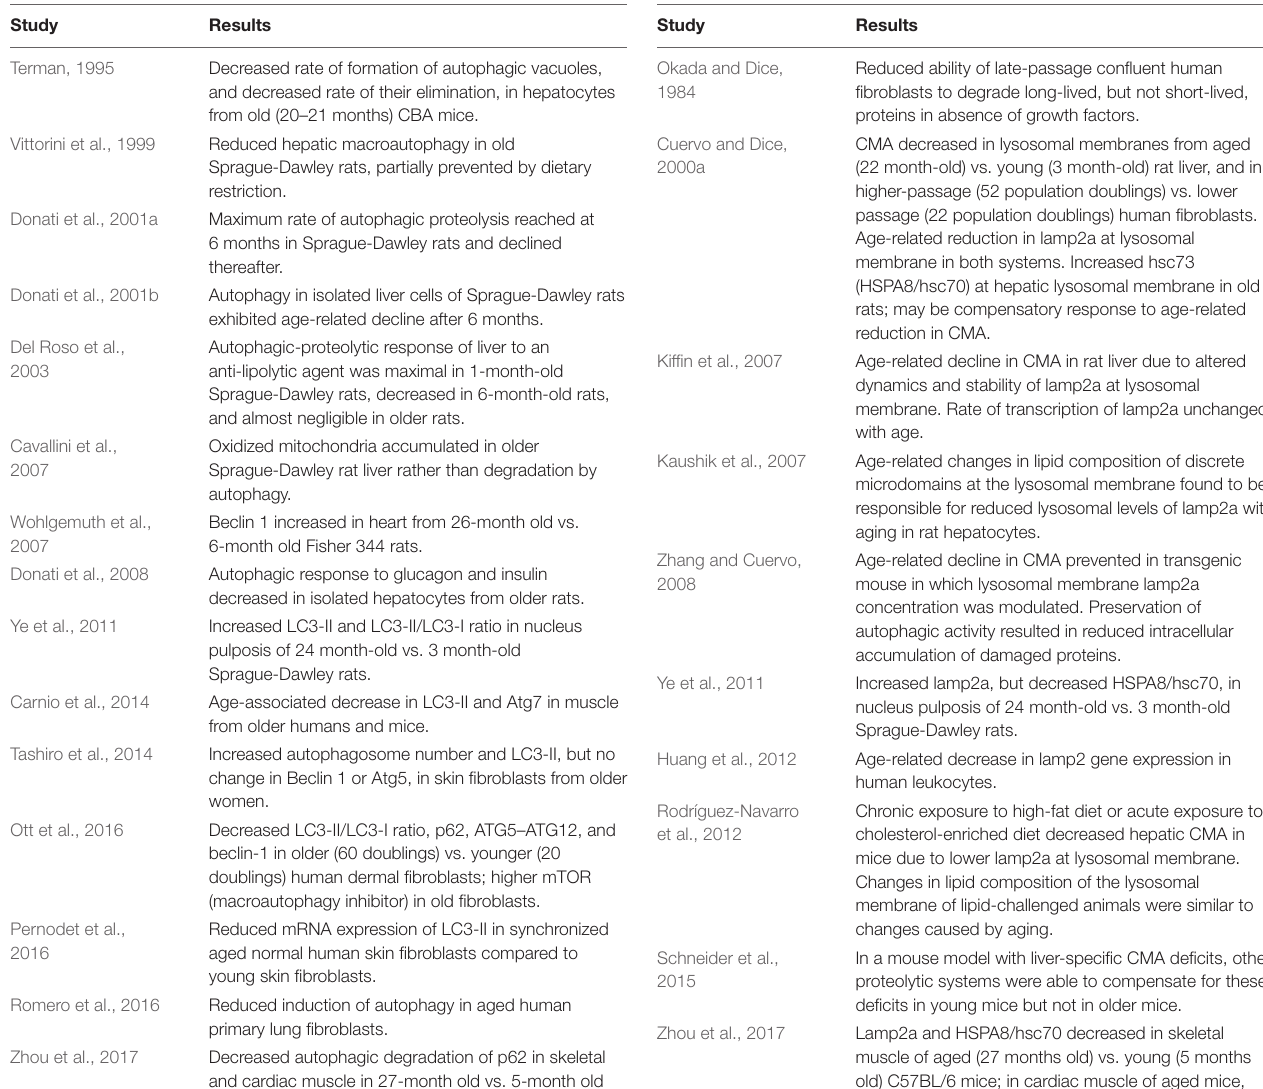
TABLE 5 | Effects of normal aging on CMA in experimental systems other than the